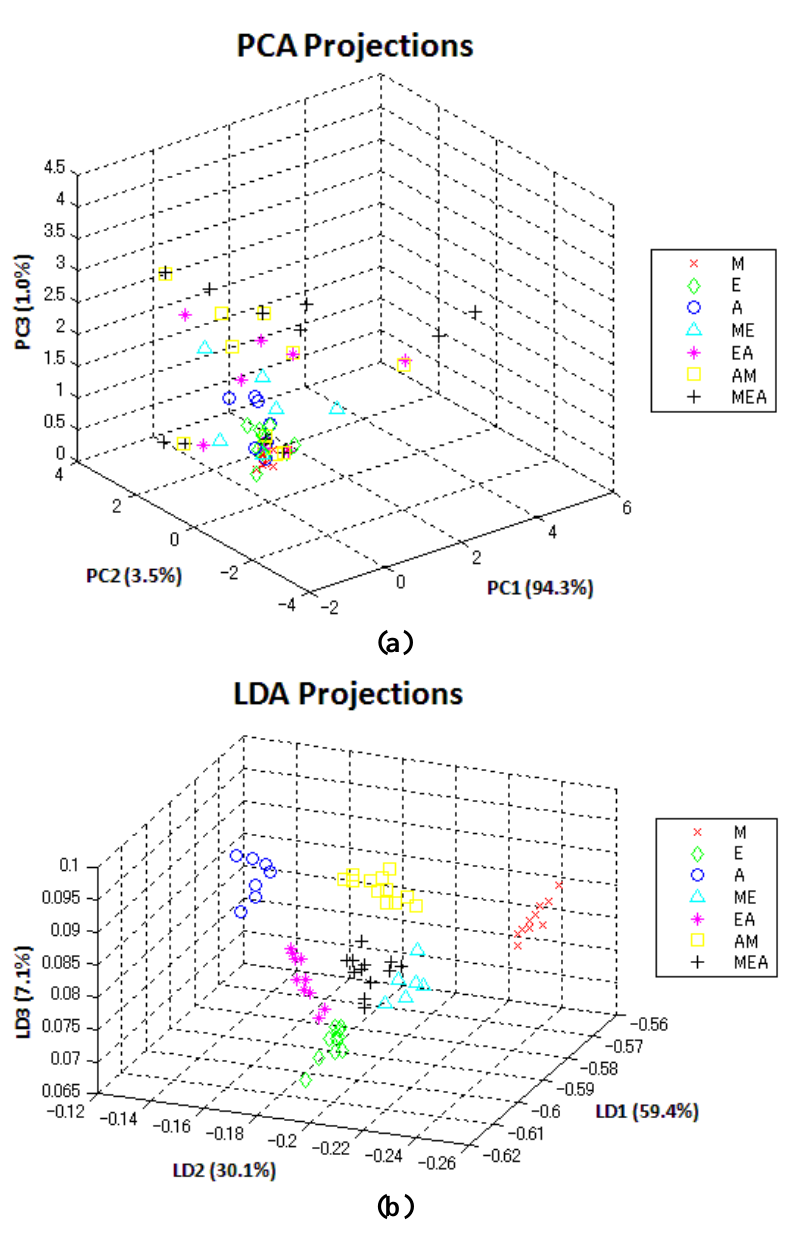
Figure 5. The projections of (a) PCA and (b) LDA over the testing